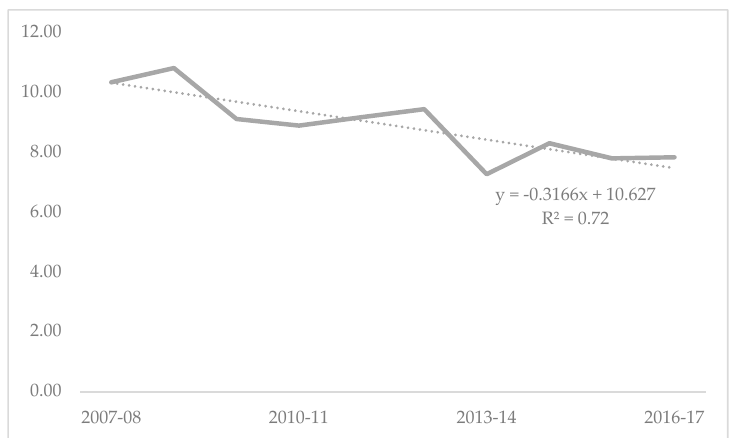
Figure 1. Crude rate per 100,000 of injury-related fatalities among children and adolescents 0–19 years, Australia 2007-08 to 2016-17.